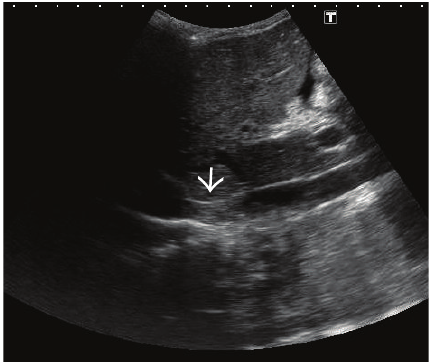
Figure 17: Gray-scale US image demonstrating echogenic thrombus in IVC (arrow).